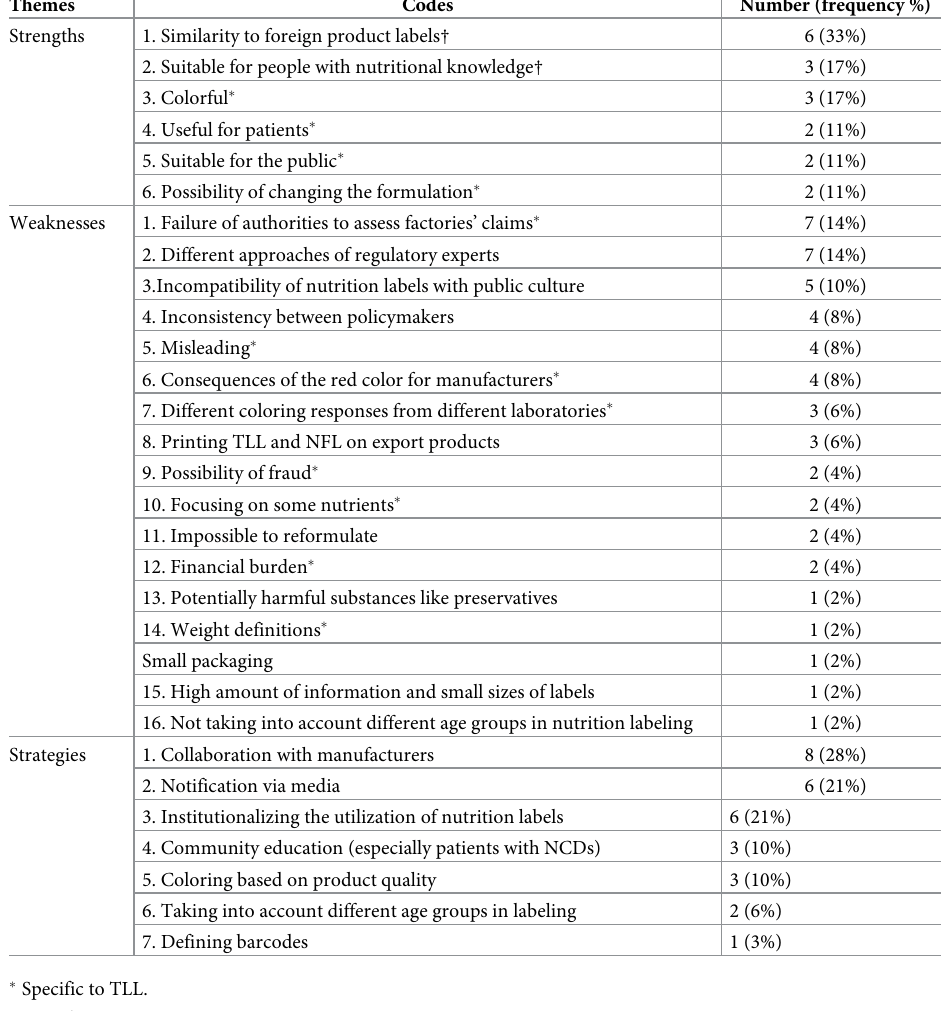
Table 4. Strengths, weaknesses and strategies for improving the use of nutrition labels, based on FQC experts’